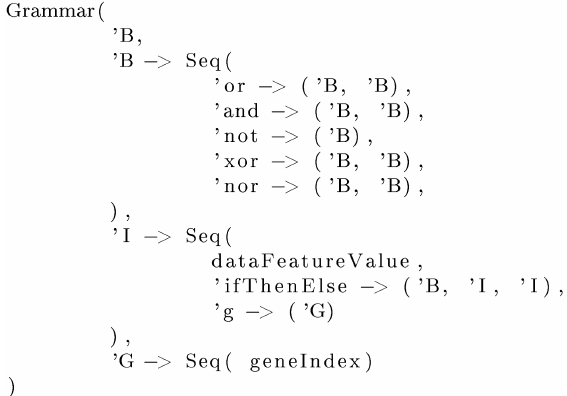
Fig. 2. Grammar describing meta-genes.